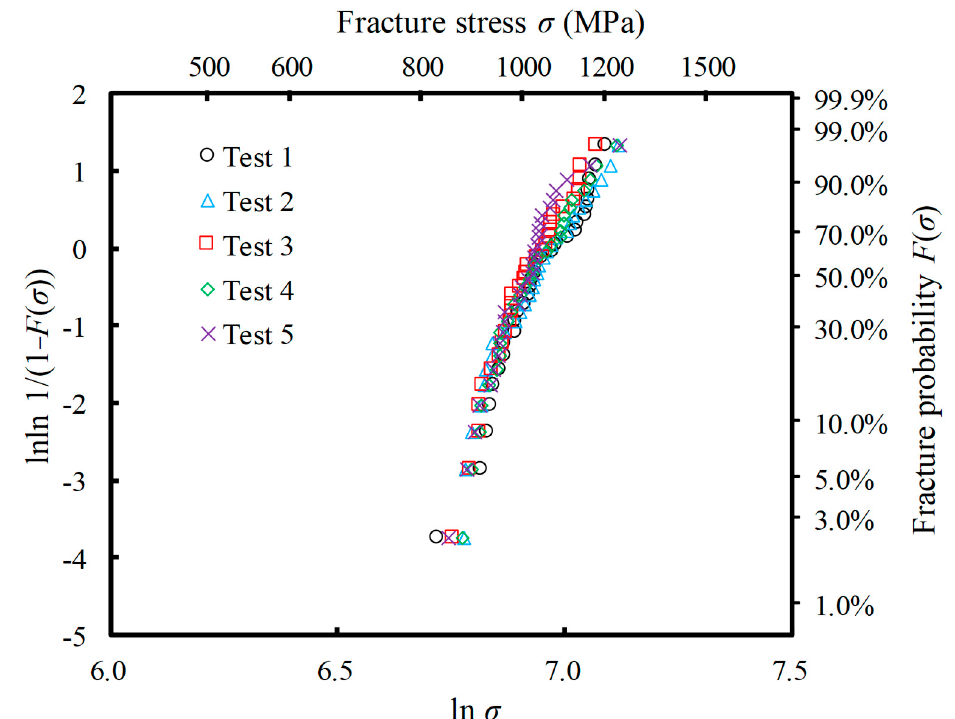
Figure 6. Weibull plots of fracture strength distributions obtained by the virtual test. This was conducted five times using FEA of the four-point bending, in which N = 30 specimens were used. The microstructure distribution condition used is given in Table 2.